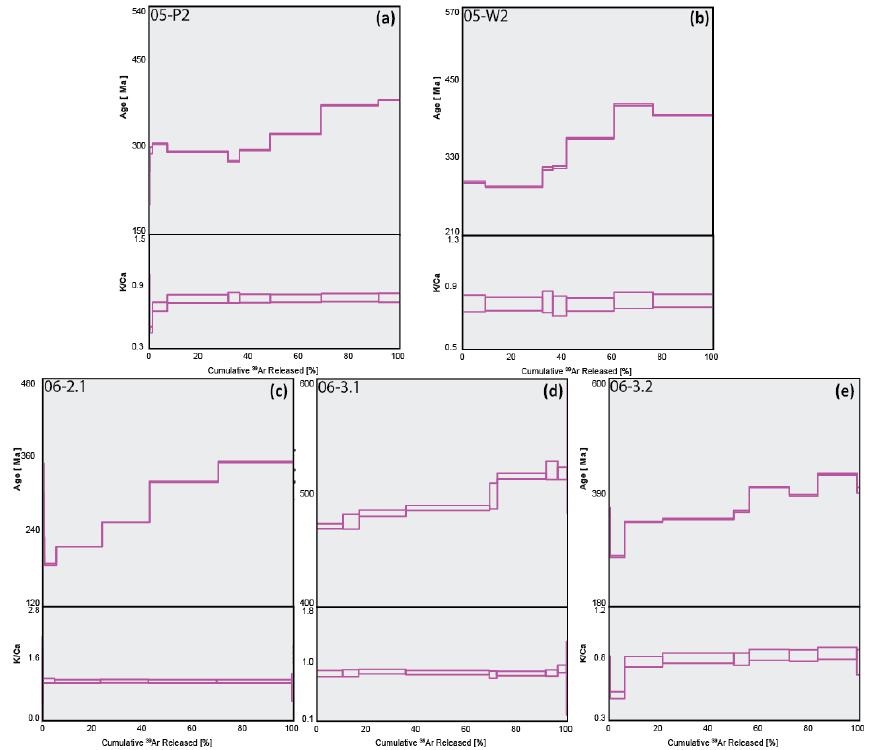
Figure 5. Combined age spectra and K / Ca plots for samples 05-P2 (a) , 05-W2 (b) , 06-2.1 (c) , 06-3.1 (d) , and 06-3.2 (e) . The thickness of individual spectra blocks is indicative of measurement